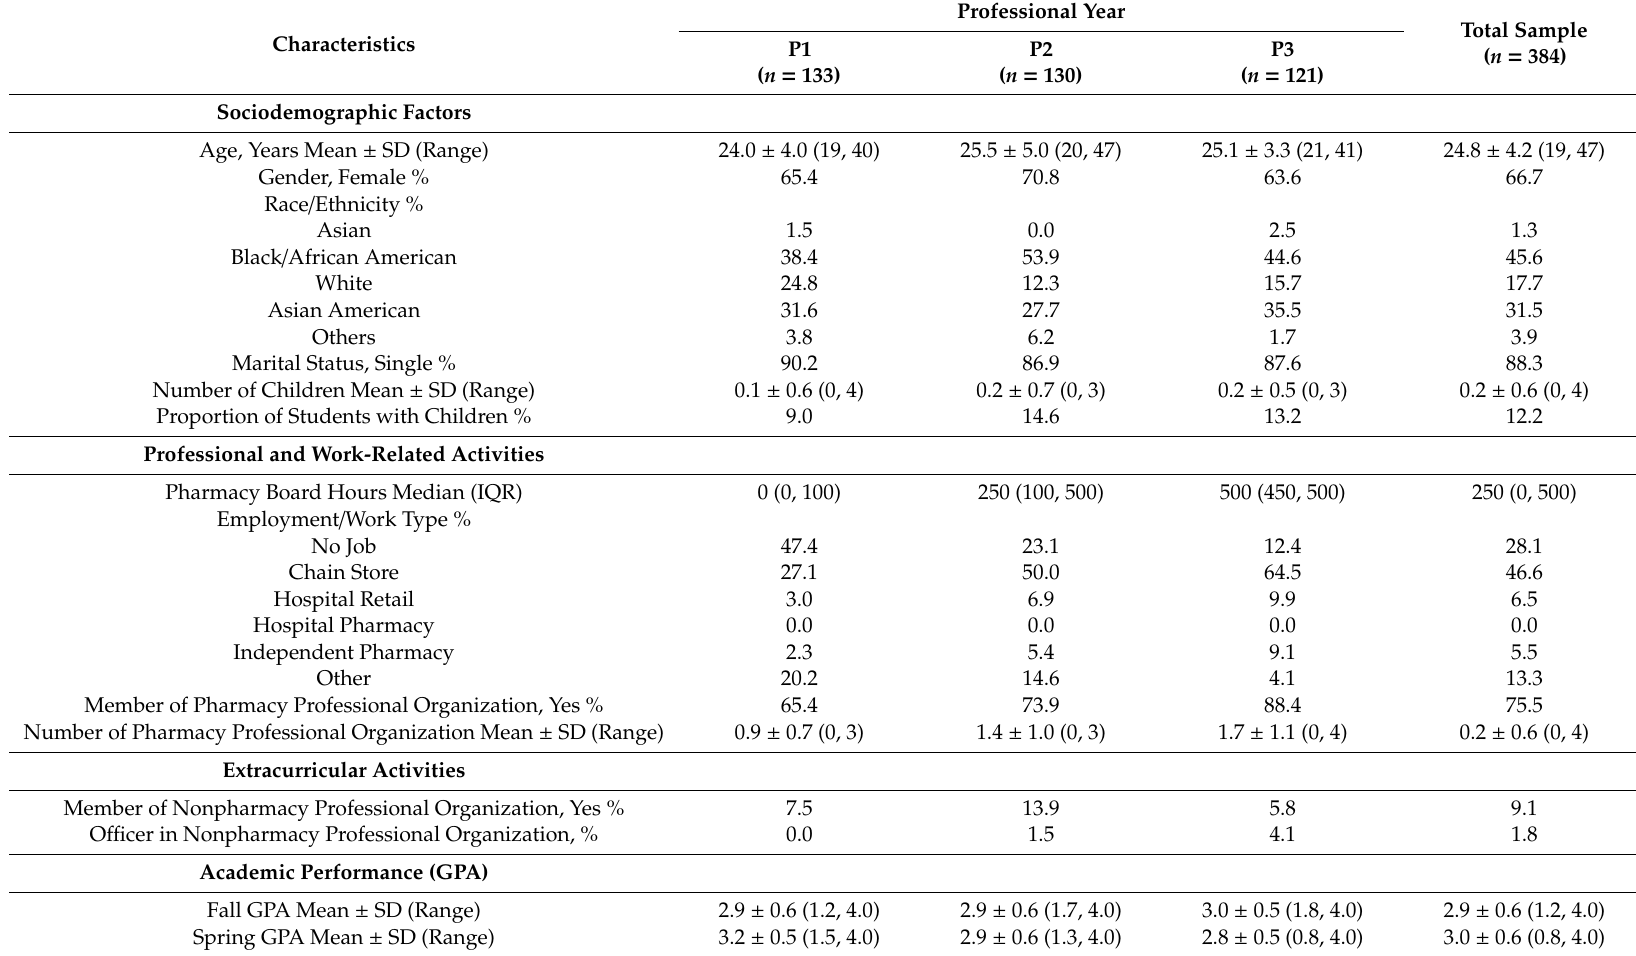
Table 2. Characteristics of study sample ( n =